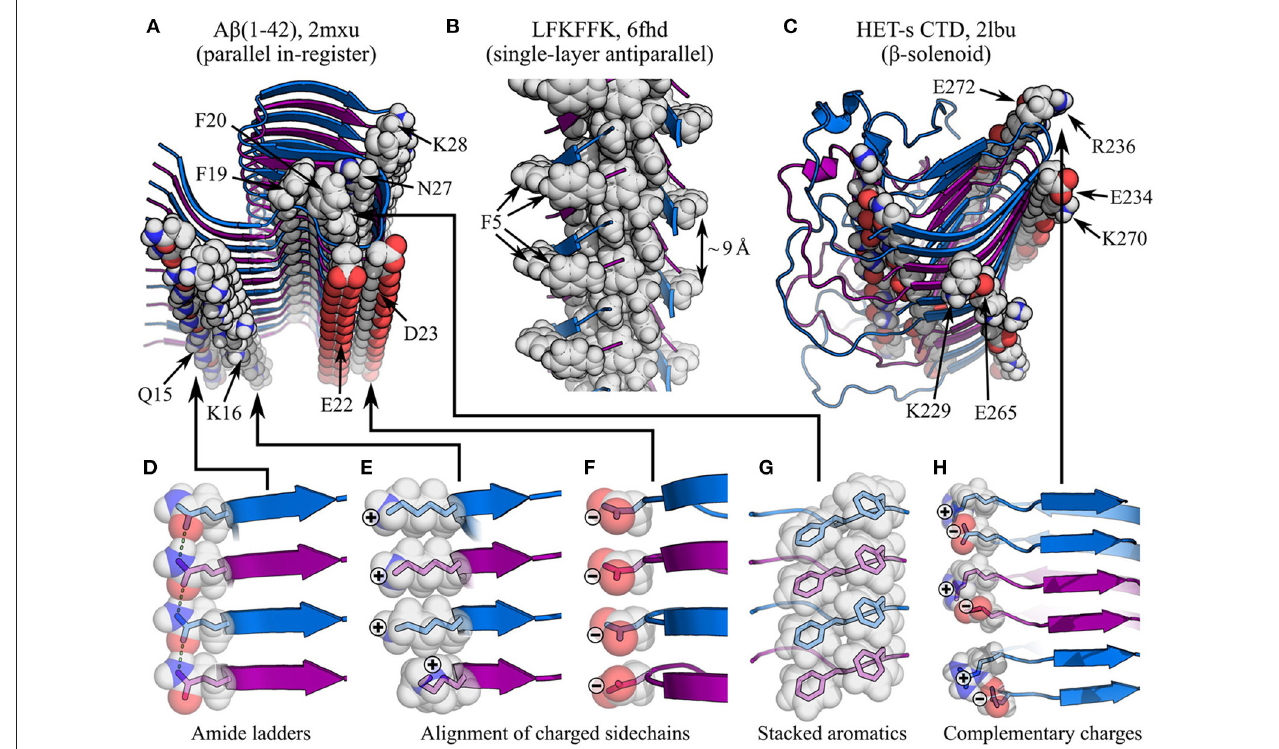
FIGURE 4 | Impact of sidechain interactions on subunit stacking. (A–C) show of segments of amyloid fibrils with different types of cross- β structure, with specific interactions highlighted: (A) parallel in-register A β (1-42) fibrils (Xiao et al., 2015), showing amide ladders (Q15 and N27), alignment of charged sidechains (K16, E22, D23, and K28), and π -stacking (F19 and F20); (B) antiparallel LFKFFK fibrils (Salinas et al., 2018), showing a π -stacked core, but sub-optimal spacing of aromatic rings around the periphery (F5); (C) the β -solenoidal HET-s CTD (Wasmer et al., 2008), showing alignment of complementarily charged sidechains (K229-E265, E234-K270, and R236-E272) and amide ladders (unlabelled). The name of the polypeptide is given above each structure, alongside the PDB ID. Structures are shown as ribbon diagrams, with adjacent subunits alternately colored blue and purple for discrimination. Sidechains of interest are highlighted as spheres, with the color scheme: gray, carbon/hydrogen; red, oxygen; blue, nitrogen. (D–H) show close-up views of specific interactions in (A–C) , with semi-transparent rendering of the spheres to show the carbon/oxygen/nitrogen bonding structure within. In (D) , sidechain-sidechain hydrogen bonds are highlighted as green dashed lines. Note that the favorable stacking of aromatics in (A,G) contrasts with the suboptimal spacing between F5 rings in (B) , although the sequence degeneracy of LFKFFK means it is still possible to form stacks of aromatics within the fibril core.